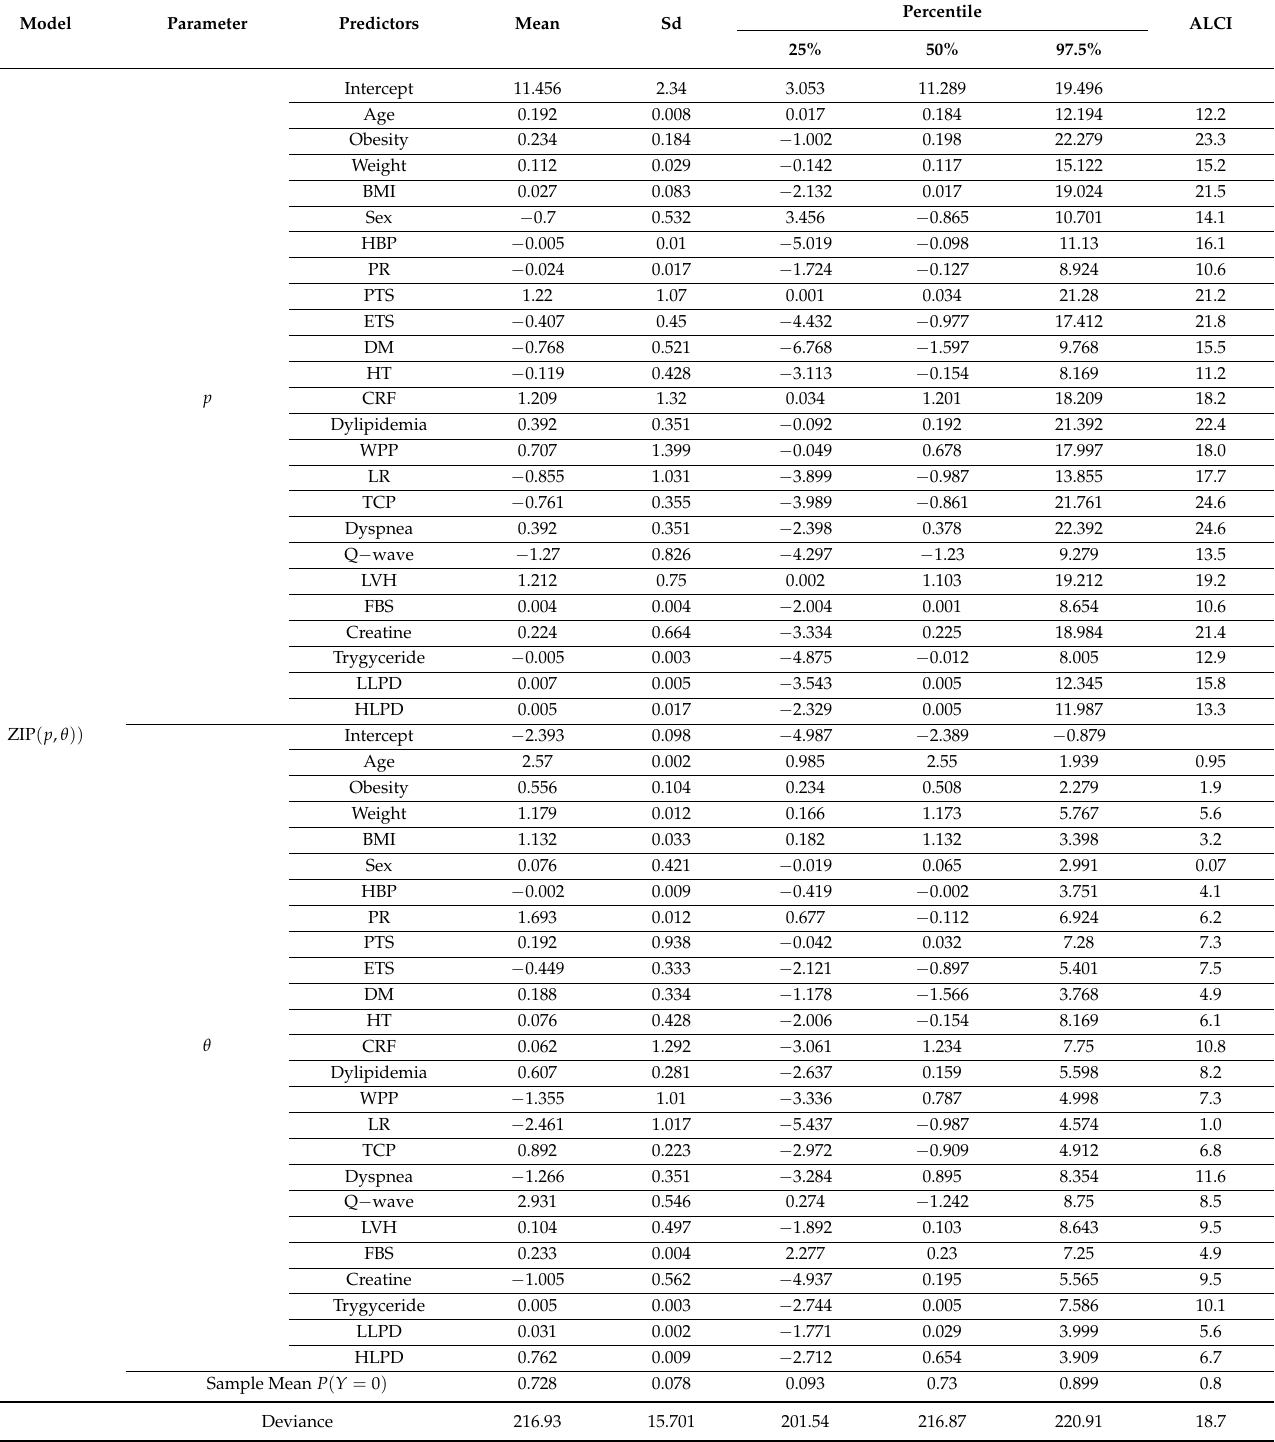
Table 2. Posterior summary of parameters (with covariates): ZIP